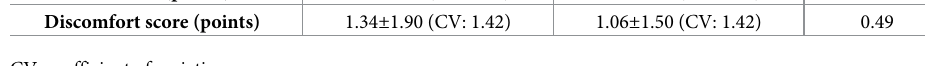
PLOS ONE | https://doi.org/10.1371/journal.pone.0284098 April 6,